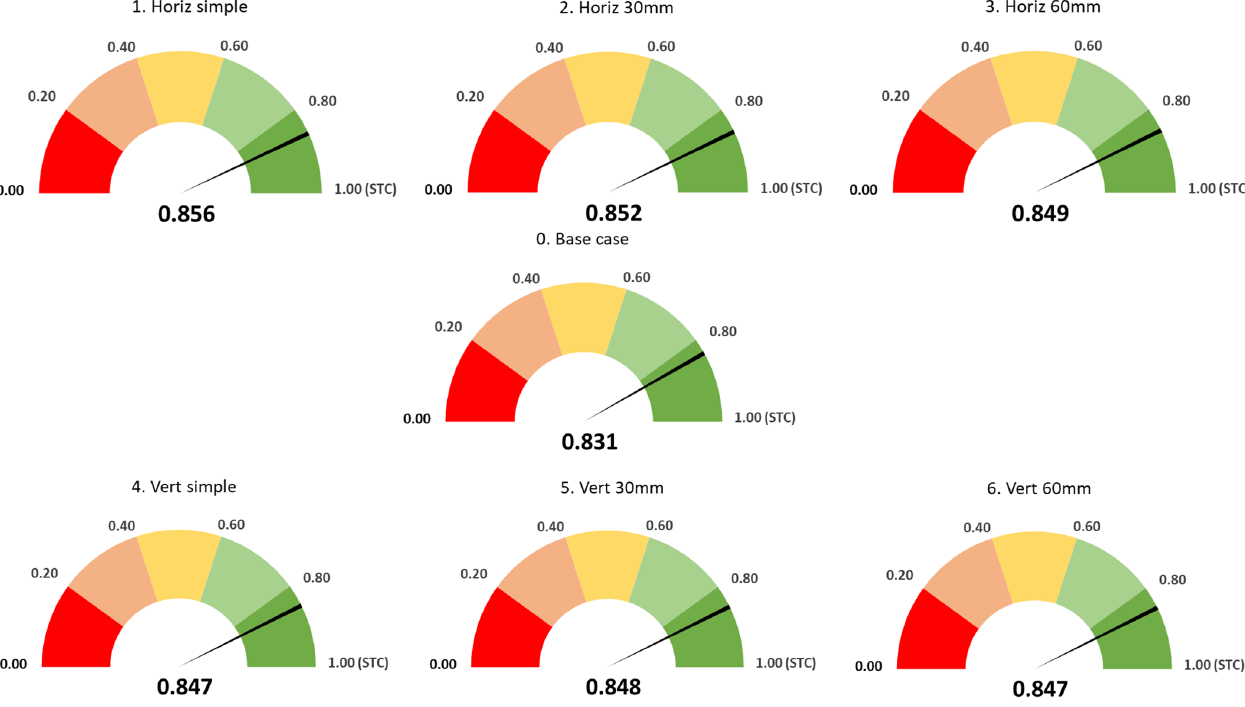
Figure 13. Normalized power production for side wind , v side = 1 m/s, t air = 35, G = 1000 W/m 2. .